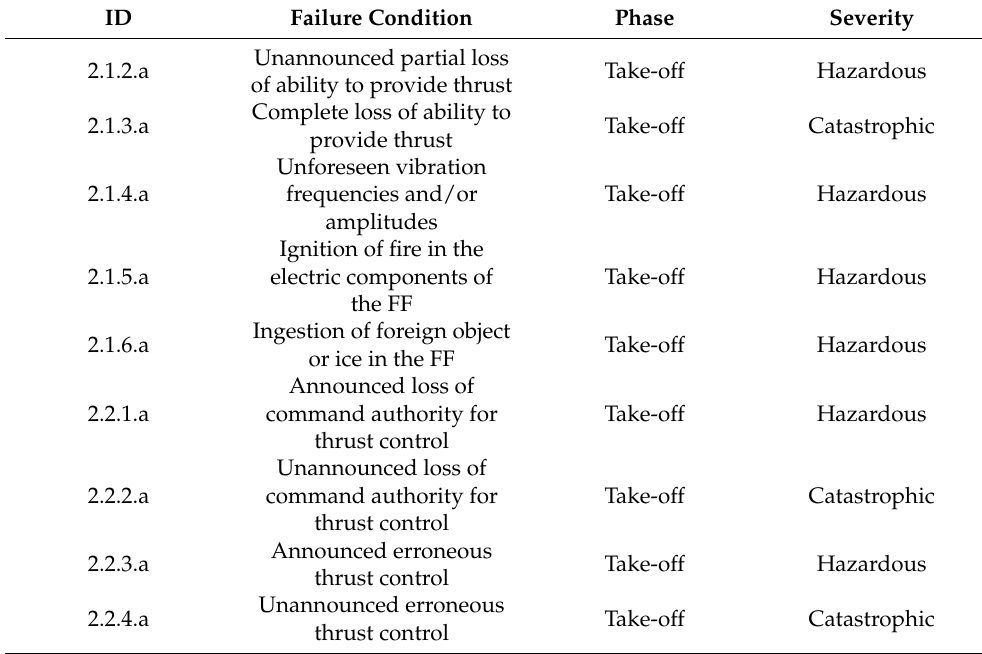
Table 13. Identified hazardous and catastrophic aircraft level failure conditions specific to the CENTRELINE PFC aircraft.